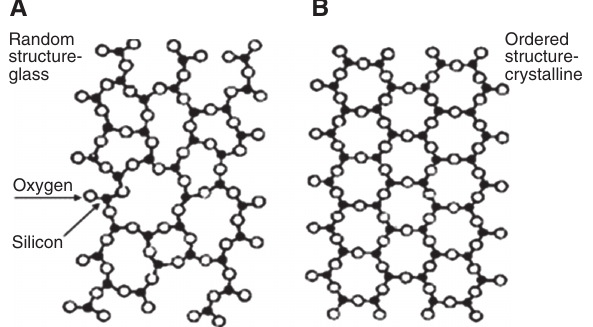
Figure 17: The structural difference between a glass and a ceramic; (A) Silica glass random structure (B) Quartz (crystallized silica) ordered structure. Image available at Ref.